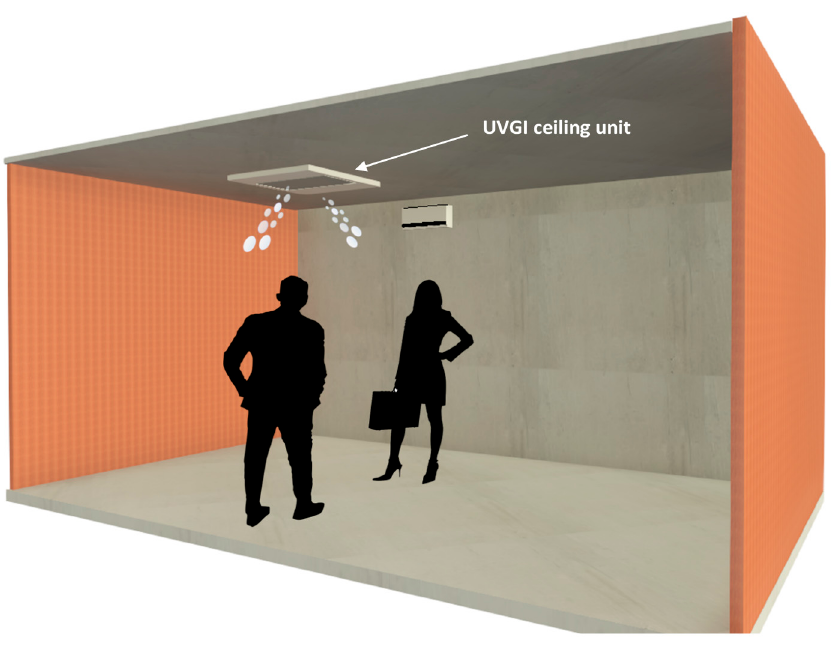
Figure 8. Potential application of a bipolar ionization device inside existing buildings.